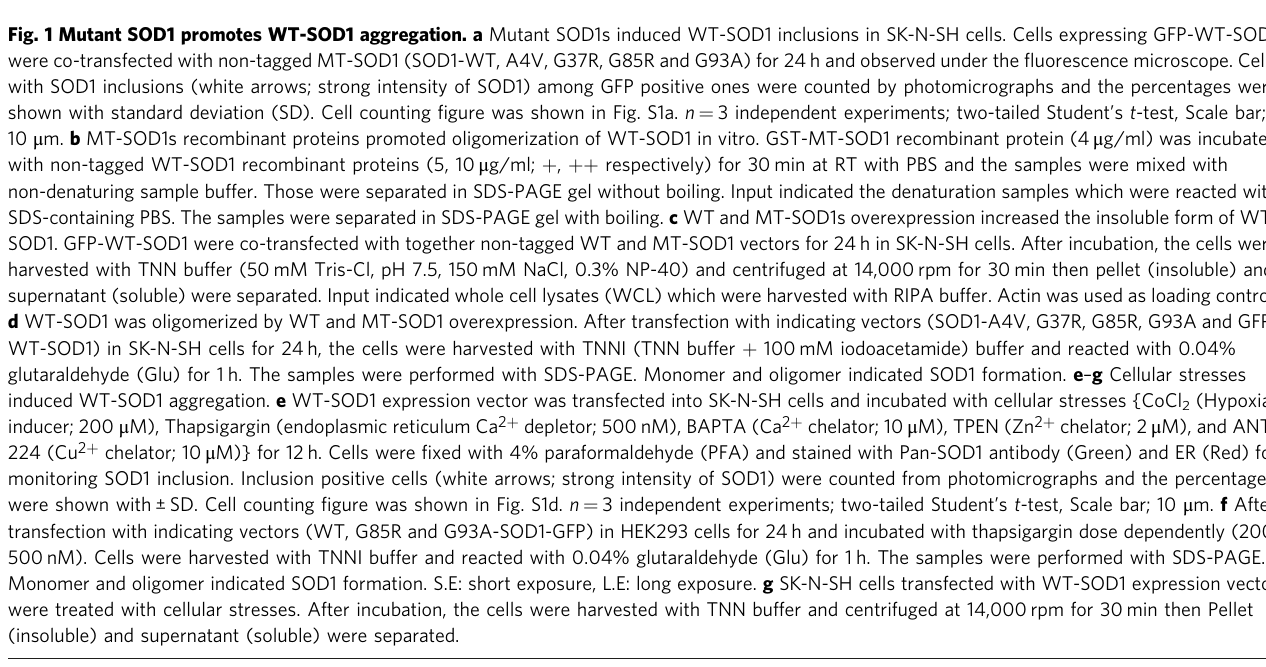
Fig. 1 Mutant SOD1 promotes WT-SOD1 aggregation. a Mutant SOD1s induced WT-SOD1 inclusions in SK-N-SH cells. Cells expressing GFP-WT-SOD1 were co-transfected with non-tagged MT-SOD1 (SOD1-WT, A4V, G37R, G85R and G93A) for 24 h and observed under the fl uorescence microscope. Cells with SOD1 inclusions (white arrows; strong intensity of SOD1) among GFP positive ones were counted by photomicrographs and the percentages were shown with standard deviation (SD). Cell counting fi gure was shown in Fig. S1a. n = 3 independent experiments; two-tailed Student ’ s t -test, Scale bar; 10 μ m. b MT-SOD1s recombinant proteins promoted oligomerization of WT-SOD1 in vitro. GST-MT-SOD1 recombinant protein (4 μ g/ml) was